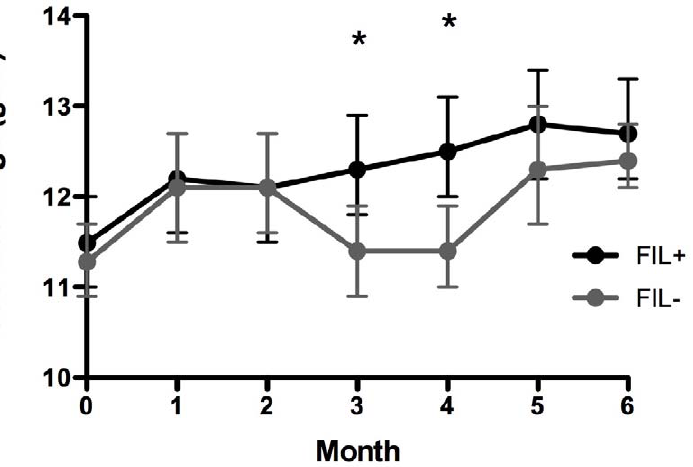
Figure 5. Hgb levels during monthly asymptomatic visits. GM Hgb with 95% confidence intervals are show for FIL + (black) and FIL 2 (gray) subjects over time. *p , 0.05,